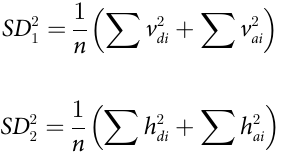
ffiffiffiffiffiffiffiffiffiffiffiffiffiffiffiffiffiffiffiffiffiffiffiffiffiffiX